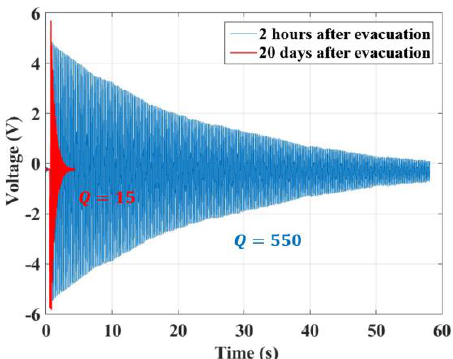
Figure 8. Pulse response curve of the accelerometer in the time domain. Pulses were supplied by the electrostatic actuator. The blue and red curves show the pulse responses at 2 h ( Q = 550) and 20 days ( Q = 15) after evacuation, respectively.